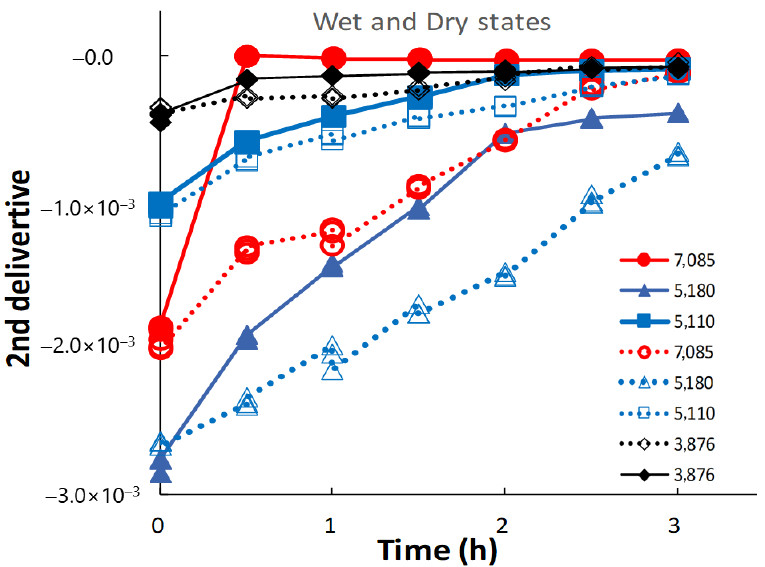
Figure 7. Changes in NIRS peak intensities at approximately 7000, 5000, and 4000 cm − 1 in the second- derivative spectra of the ground S-CP products during wet and dry grinding. The solid and dotted lines indicate the changes in the intensity owing to wet and dry grinding, respectively.